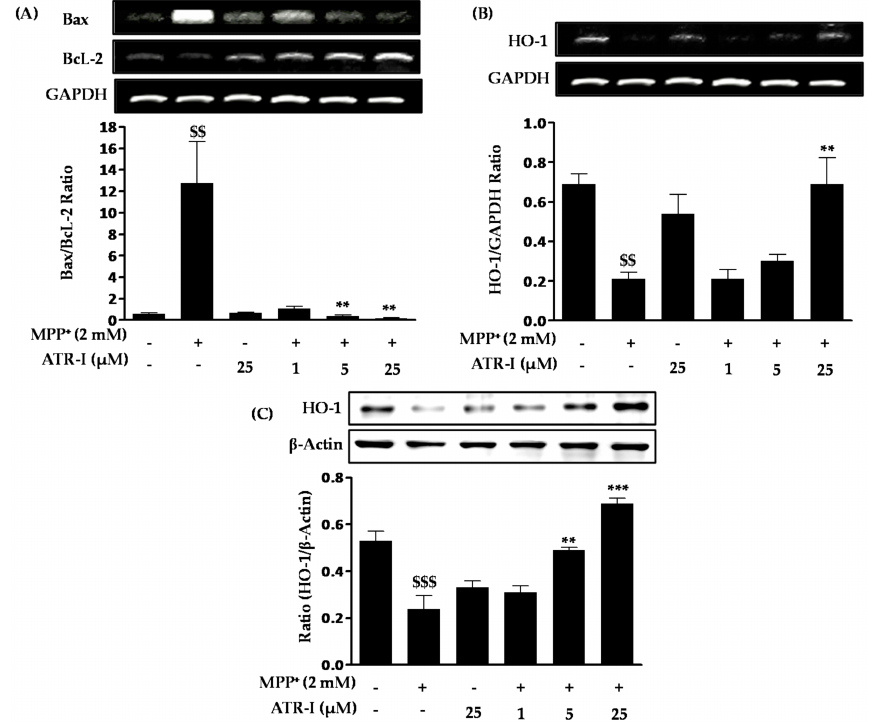
Figure 2. ( A ) Effects of ATR-I on the Bax/Bcl-2 mRNA ratio in MPP + -stimulated SH-SY5Y cells. The levels of ( B ) HO-1 mRNA and ( C ) HO-1 protein expression were quantitated by densitometric analysis. Quantification data are shown in the lower panel. Glyceraldehyde-3-phosphate dehydrogenase (GAPDH) and β -actin were used as internal controls. $$$ p < 0.001 and $$ p < 0.01 vs. the vehicle group; *** p < 0.001 and ** p < 0.01 vs. the MPP + -treated